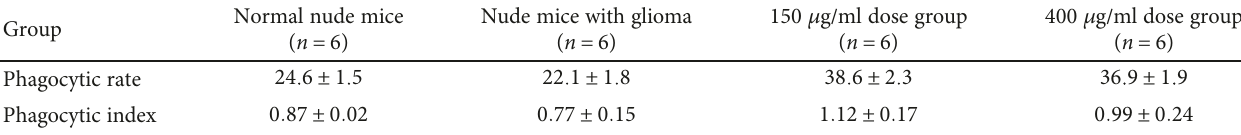
Table 1: Enhancement of phagocytosis of macrophages in nude mice with glioma by radix hedysari polysaccharide. Group